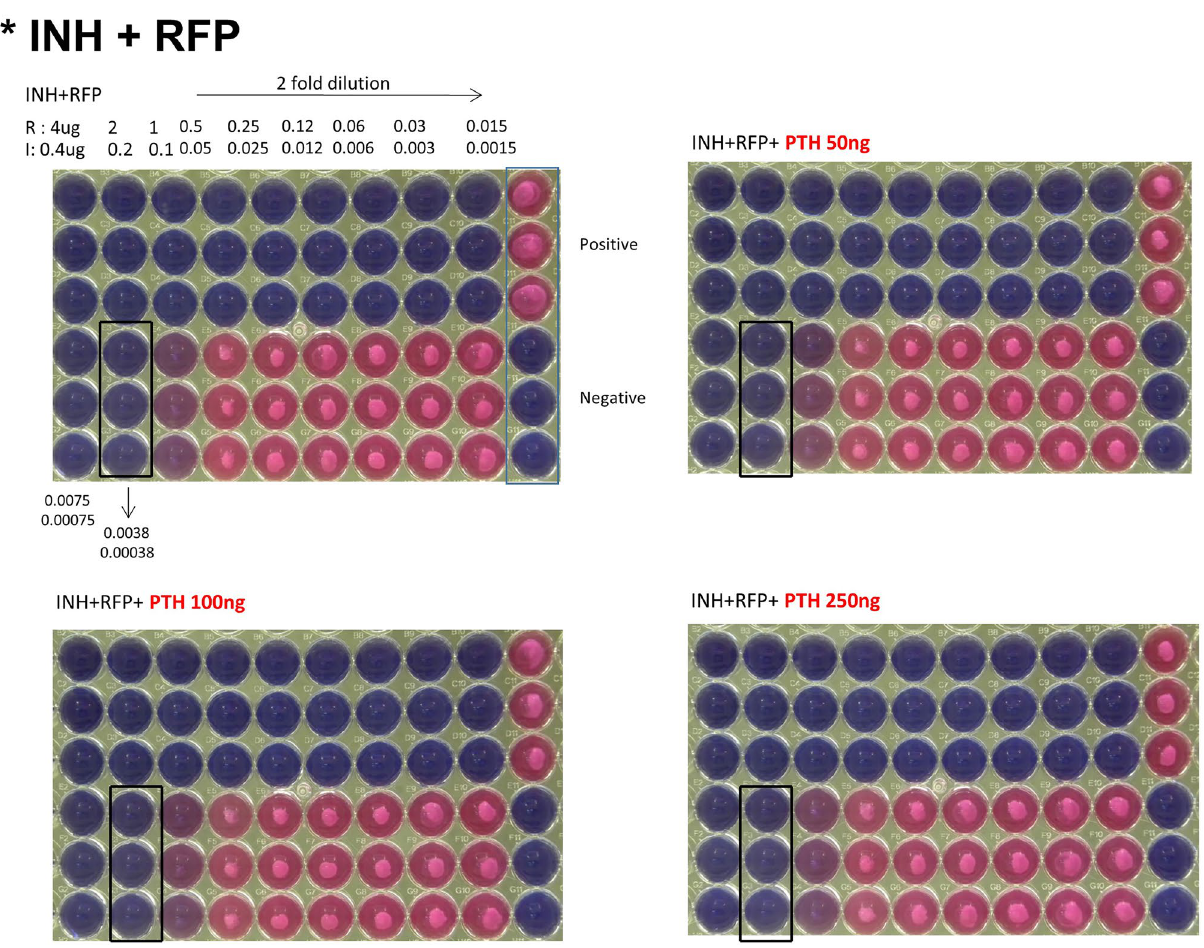
Figure 1. Minimum inhibitory concentration (MIC) assay of isoniazid plus rifampicin (INH + RFP) according to various teriparatide concentration (0, 50, 100, and 250 ng). Abbreviations: INH, isoniazid; PTH, teriparatide; RFP,